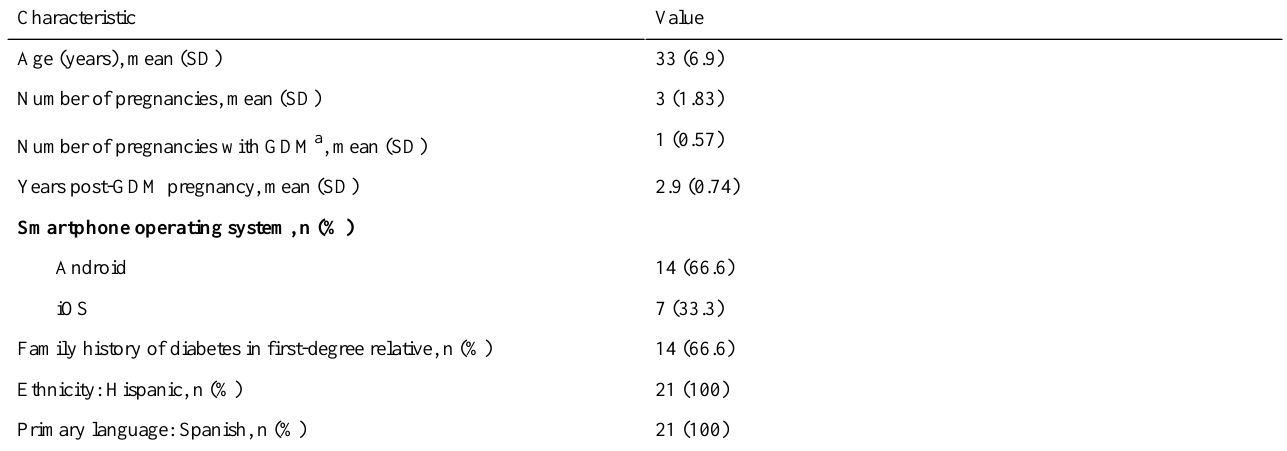
Table 2. Baseline characteristics of the study population